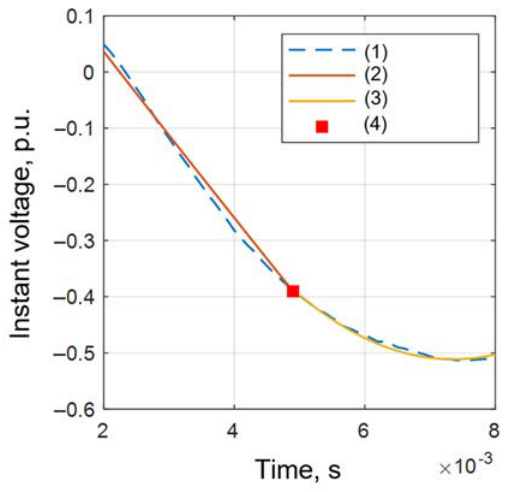
Figure 4. An example of joint point forming.